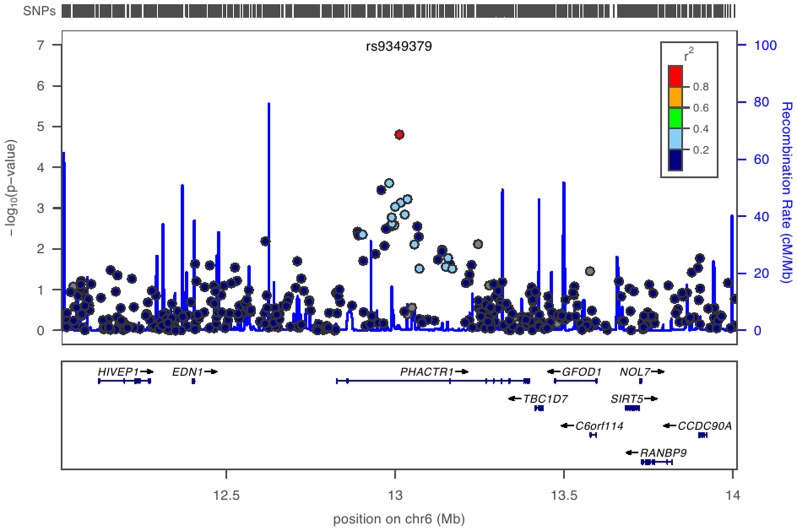
Map around the PHACTR1 locus on chromosome 6 showing strong evidence of association with coronary artery stenosis.The upper vertical bars correspond to the location of all markers tested from the SNP array chip in the area. The X-axis indicates the chromosomal position in base-pairs on chromosome 6. Recombination rate is presented as a continuous blue line, while individual markers are represented by a circle filled with a color corresponding to the extent of LD with the key marker rs9349379 (in red) from dark blue (r2 = 0) to red (r2 = 1). Grey filled circles refer to SNPs with no LD information. The lower part represents the location of the genes with corresponding exons and the direction of transcription indicated by arrows. The figure was generated with LocusZoom using CEU from HapMap release 22 as reference.